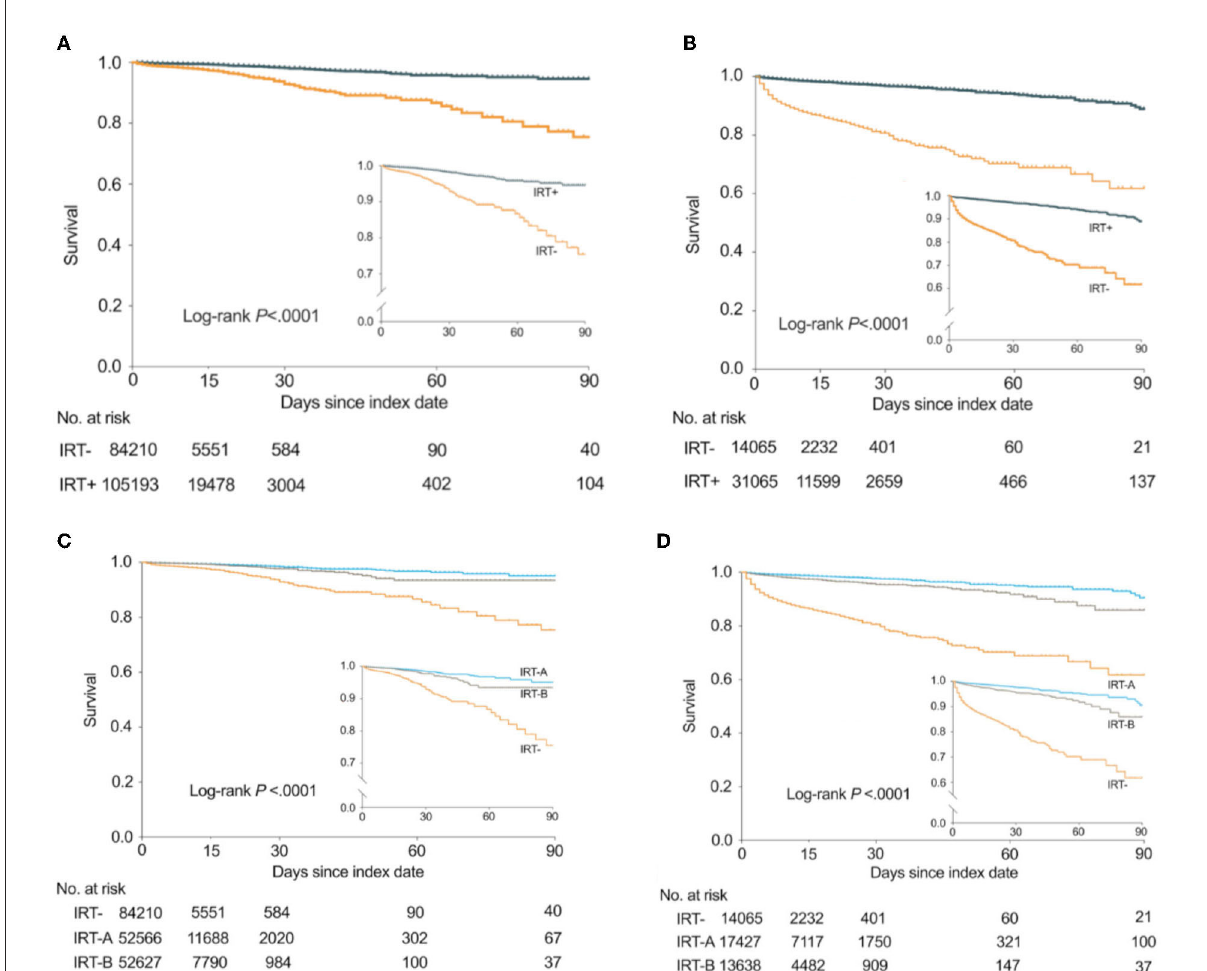
FIGURE2 Kaplan-Meier curves showing the probability of survival in the thrombolysis-only group and the EVT group. EVT, endovascular therapy; IRT-A, interventions with PT or OT; IRT-B, interventions without PT/OT. The number of observations was 189,403 in the thrombolysis-only group and 45,130 in the EVT group, for exclusion of missing data on follow-up times. (A) In the thrombolysis-only group, the probability of survival between IRT- and IRT+ subgroups. (B) In the EVT group, the probability of survival between IRT- and IRT+ subgroups. (C) In